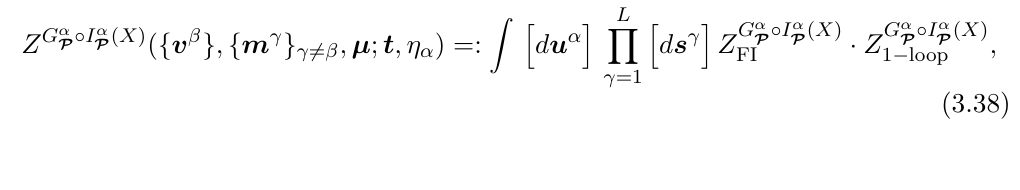
Figure 12 . This figure illustrates the flavoring-gauging operation G α quiver X at the flavor node U( M